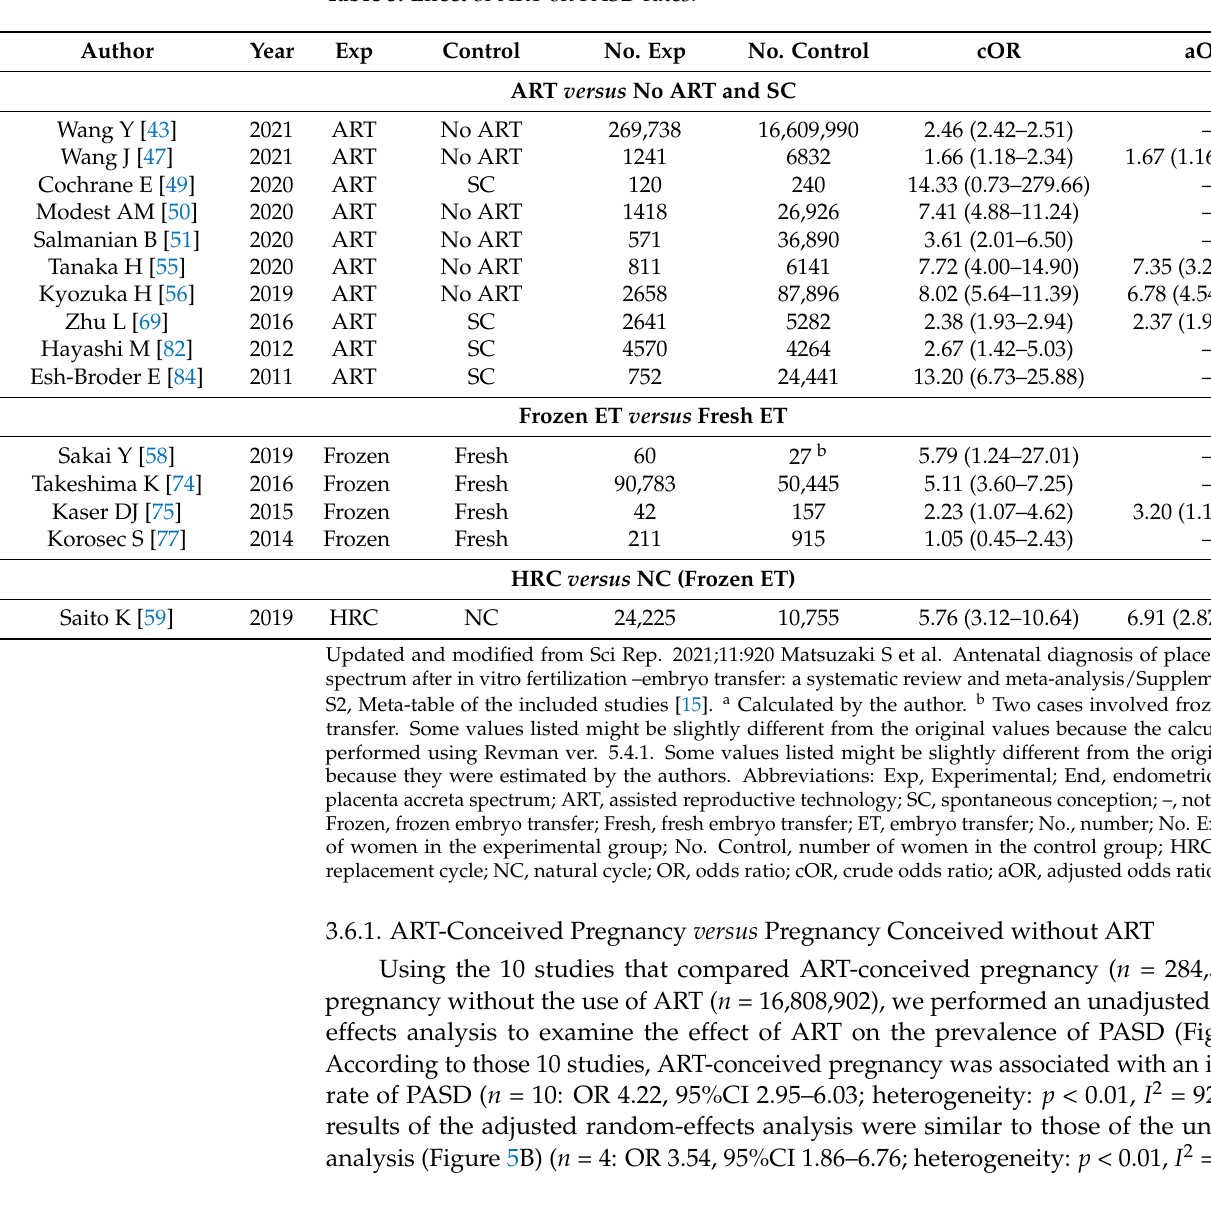
Table 5. Effect of ART on PASD